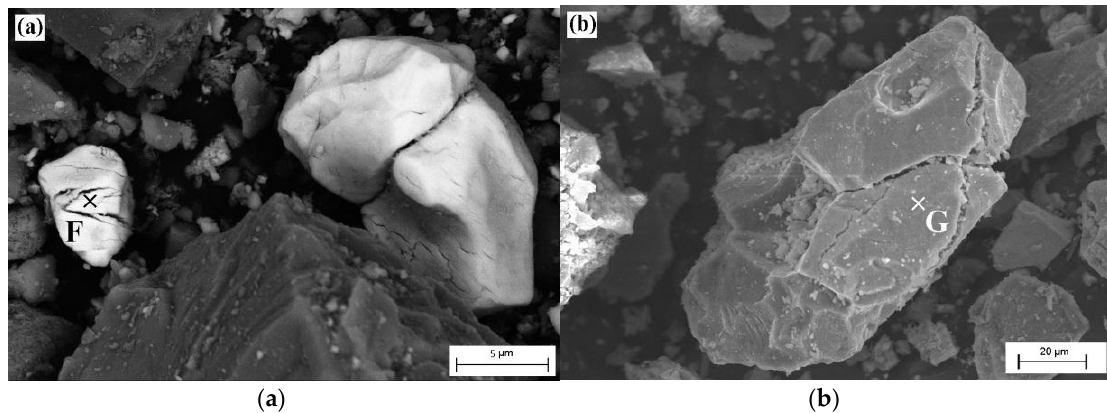
Figure 9. SEM images of mineralogical phases in Bayan Obo tailings after magnetizing roasting at 600 °C ( a and b ): (F) roasted bastnaesite; (G) Fe 3 O 4 .